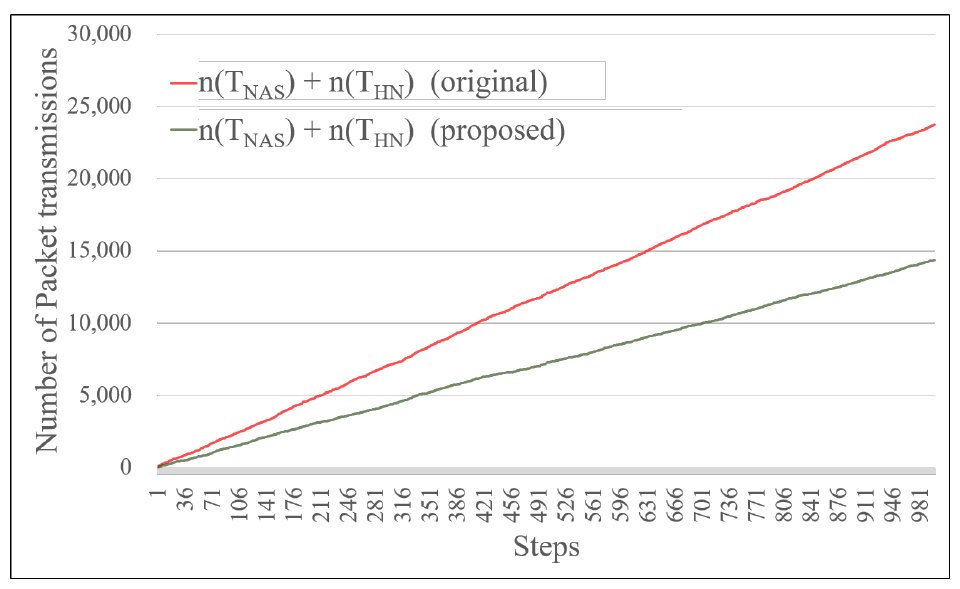
Figure 8. Number of packets transmitted in the Non-Access Stratum (NAS) domain.